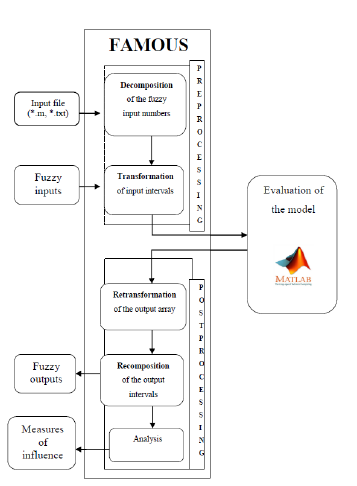
Figure 1. Structure of the software FAMOUS